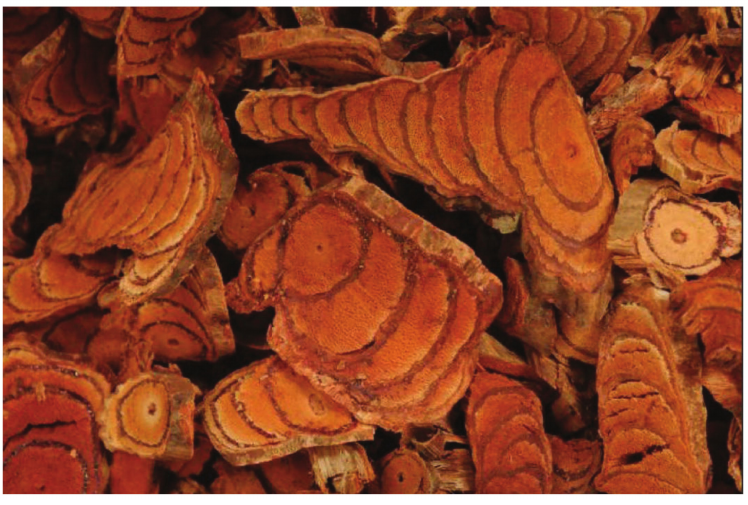
Figure 1. The dry stem of